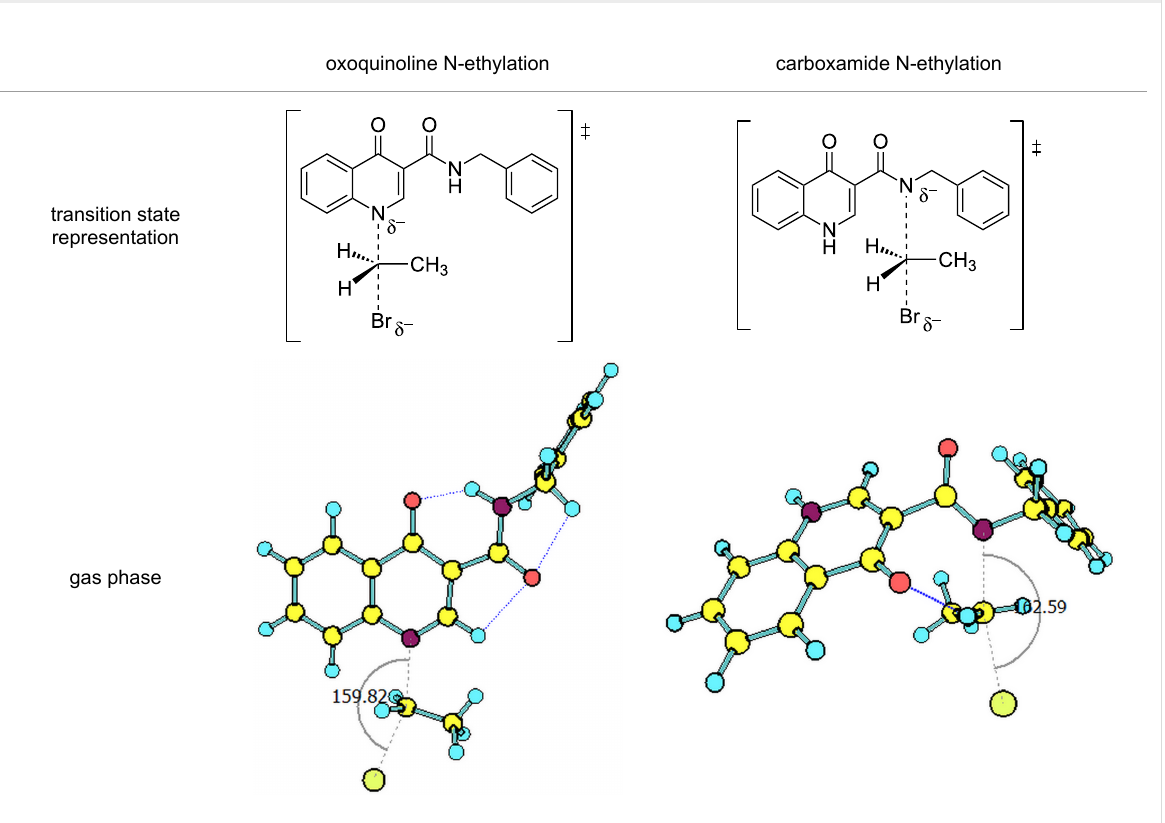
Table 4: Transition states associated with both reaction